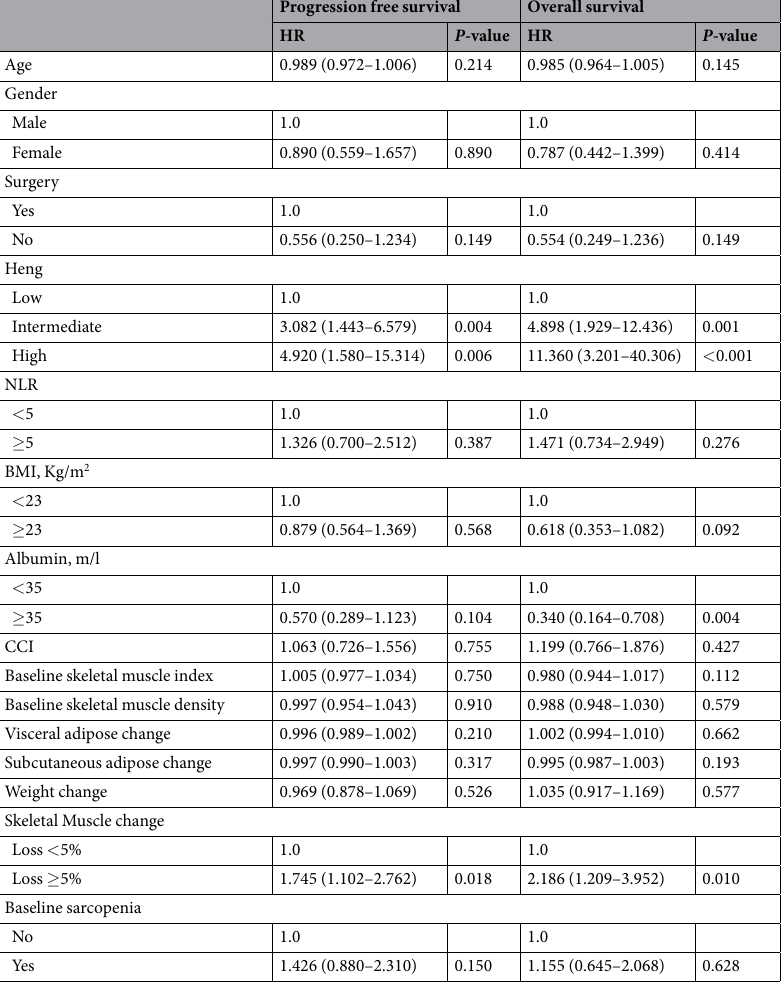
Table 2. Univariate Survival analysis. Abbreviation: BMI: body mass index NLR: Neutrophil to lymphocyte ratio CCI: Charlson comorbidity